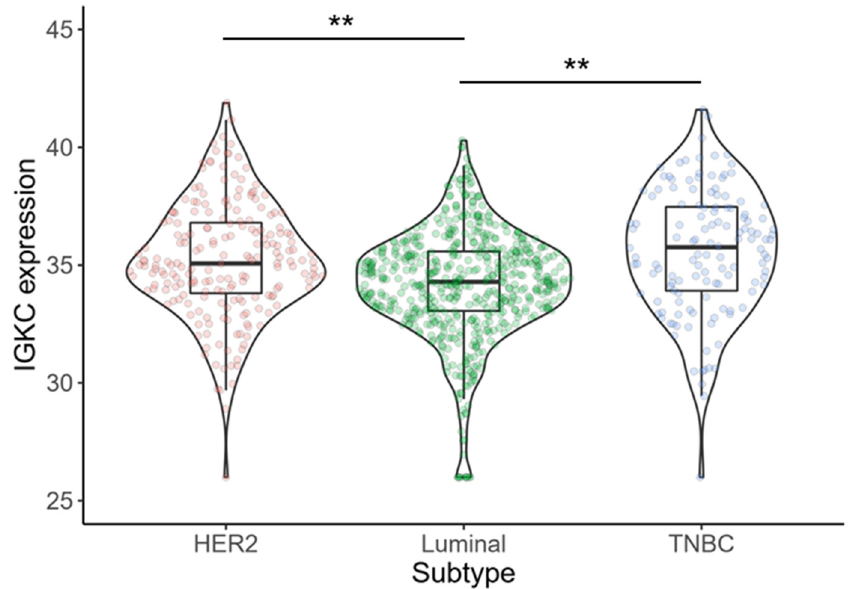
Figure 2. Statistically significant association of IGKC expression and molecular subtype ( p < 0.001; one-way ANOVA). Triple-negative cancers and HER2-positive cancers show higher expression of IGKC mRNA compared to luminal cancers. ** p < 0.001 .